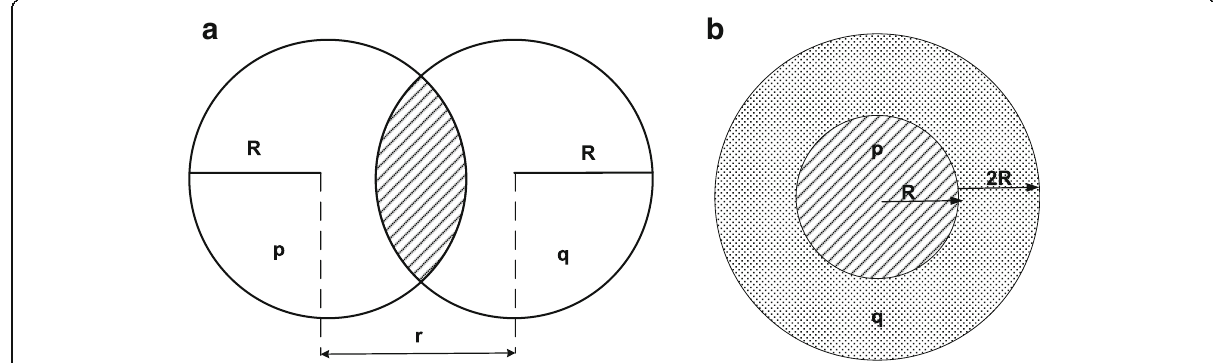
Fig. 9 Analysis of 1-hop and 2-hop neighbours. a Intersecting area of overlap between two disks and b two disks imitating 1-hop and 2-hop